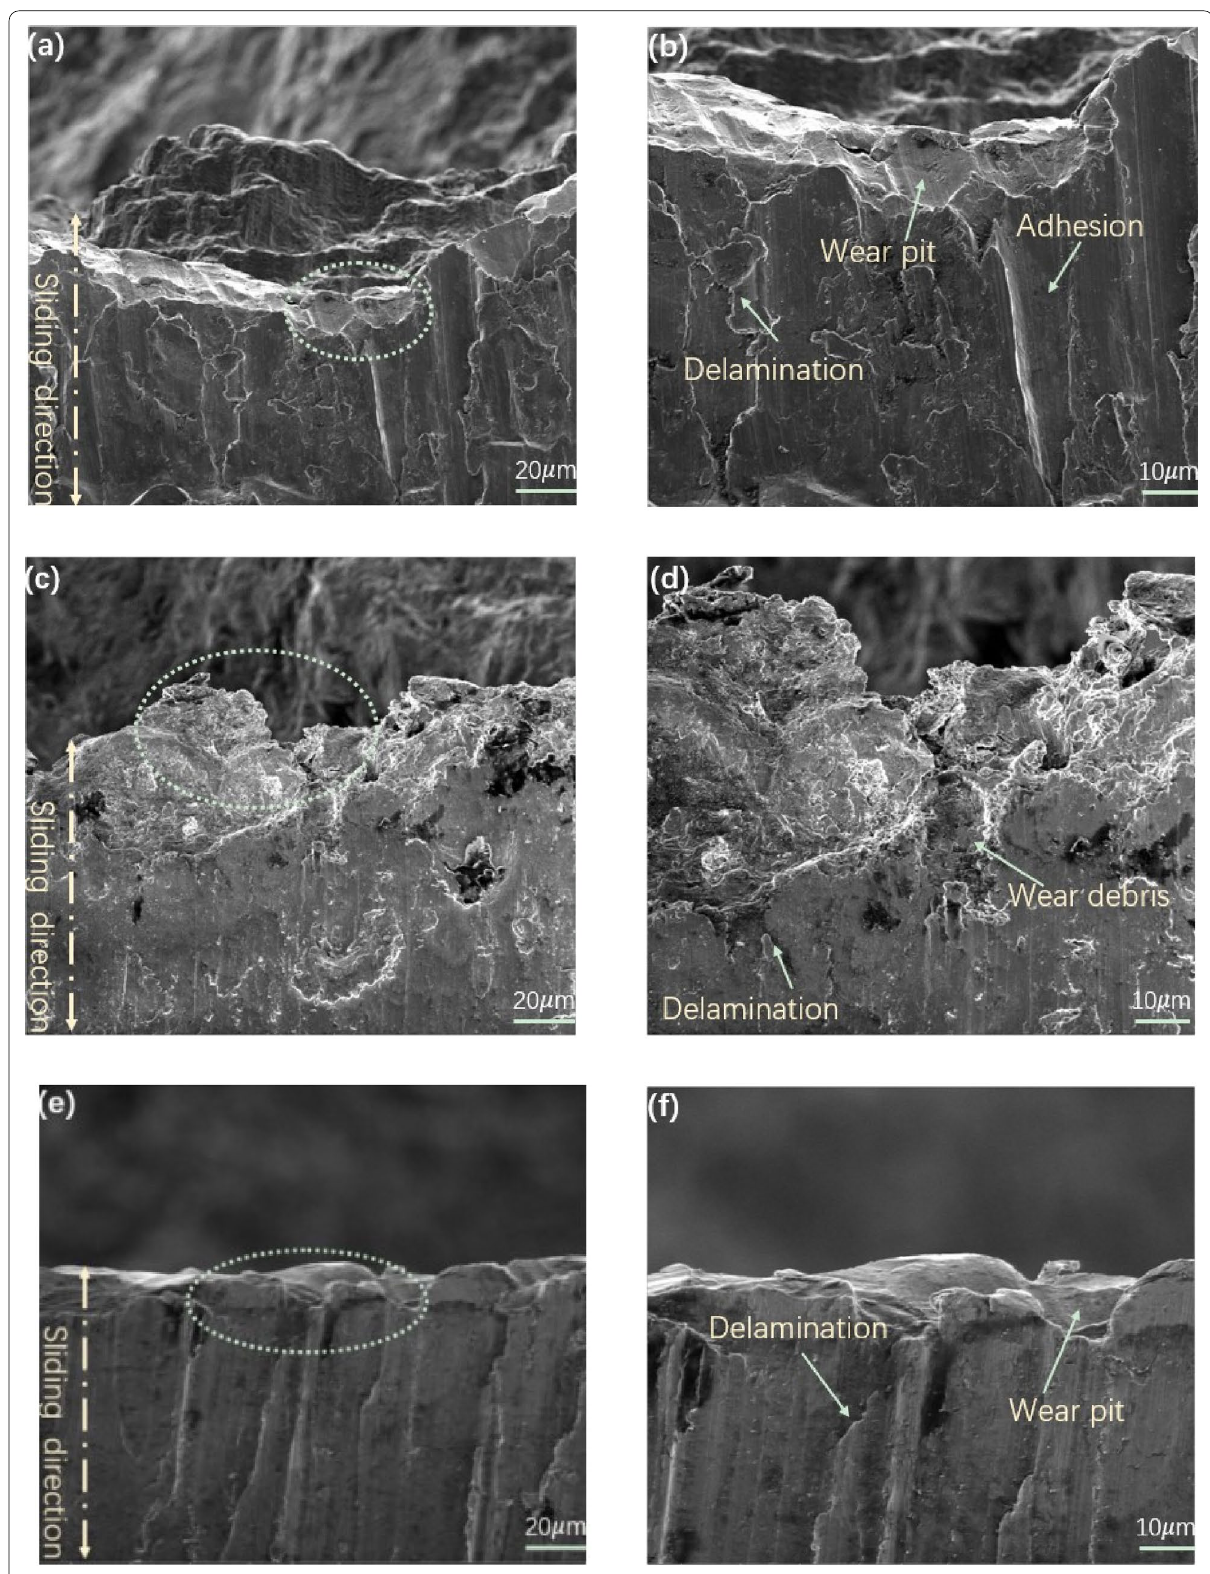
Figure 15 SEM images of the typical wear morphologies of a , b AsR specimen, c , d SP specimen and e , f USRP